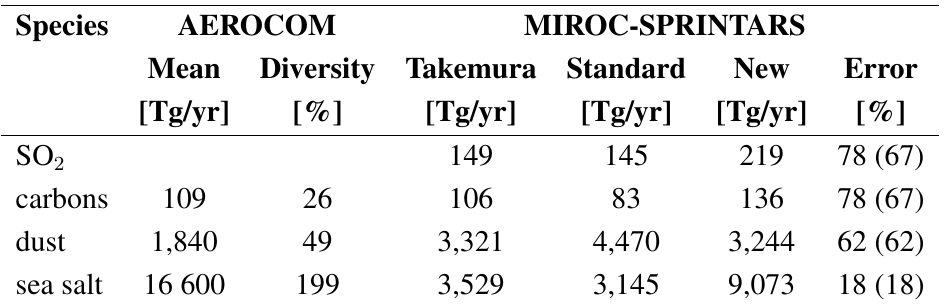
Table 2. Aerosol emissions according to various